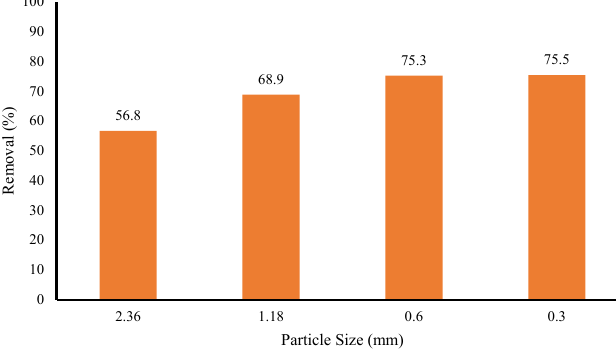
Fig. 5: Influence of bamboo activated carbon for removing nickel from electroplating industry wastewater against the particle size